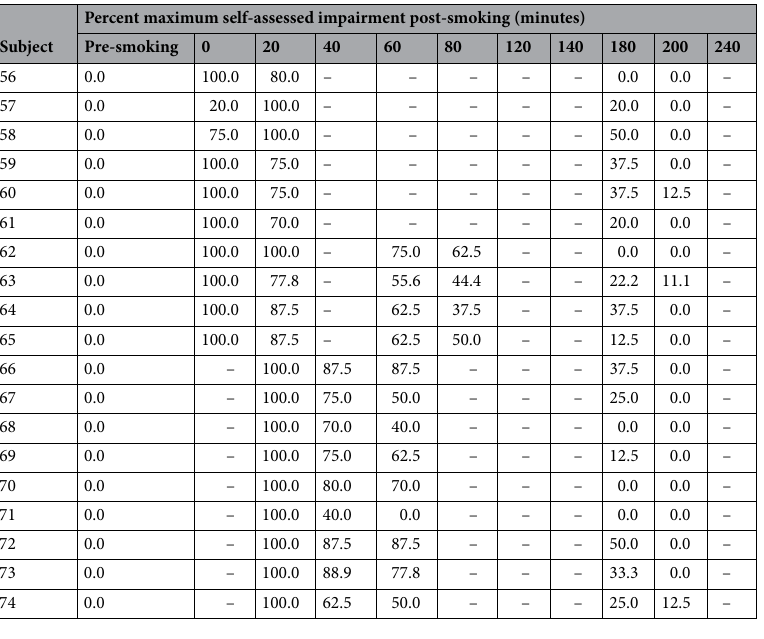
Table 1. Percent maximum self-assessed impairment. *Dashes indicate subjects were not sampled at these time points. † Subject failed to complete the self-assessment